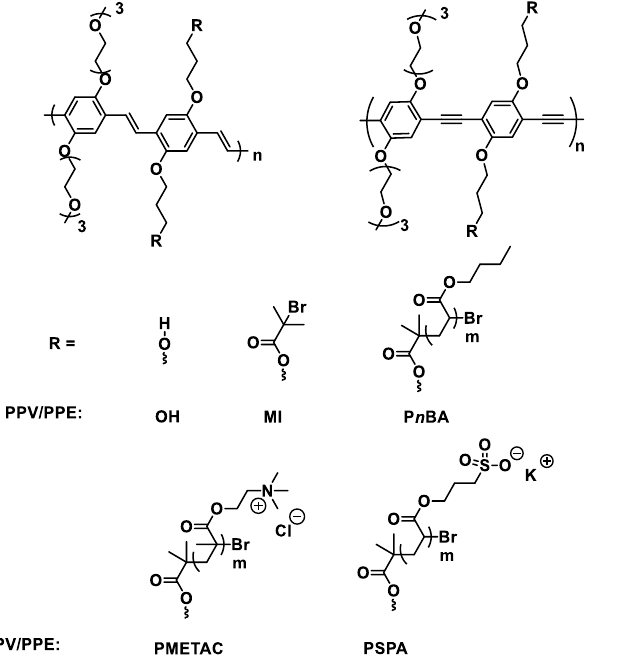
Figure 1. Chemical structures for the PPV and PPE macroinitiators and the resulting